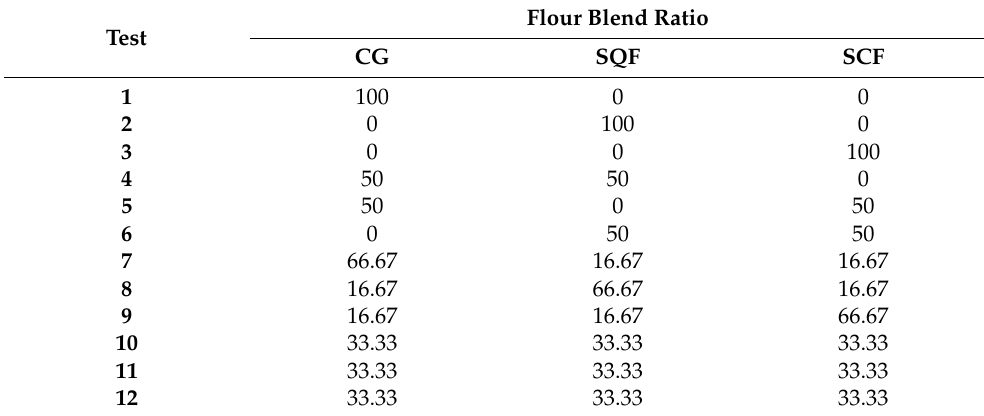
Table 1. Simplex centroid mixture design including 12 experimental flour